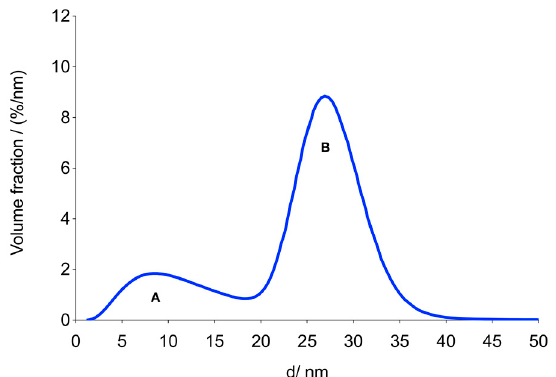
Figure 5. Bimodal volume distribution of MCP 3 with modes A and B calculated from the M(H) data. It is probable that only mode B contributes significantly to the MPS/MPI signal. Table 2. Fit parameters obtained from the analysis of the M(H) data.